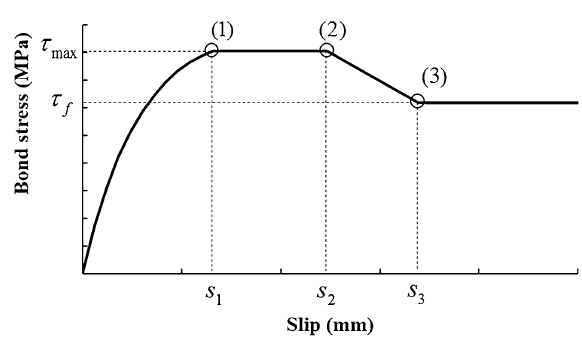
Fig. 7 Modeling of the bond stress–slip relationships for the strand in the concrete at different t e